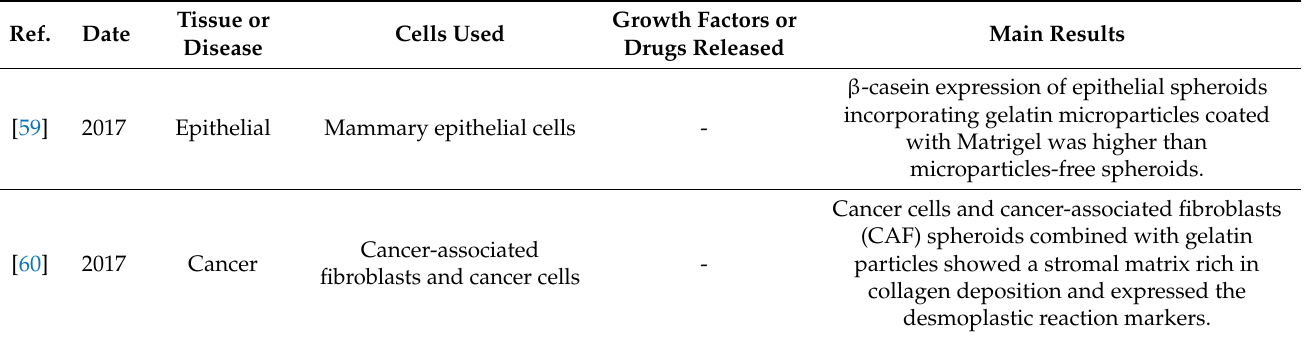
Table 3. In vitro drug research studies using 3D cell/tissue spheroids combined with gelatin microparticles.